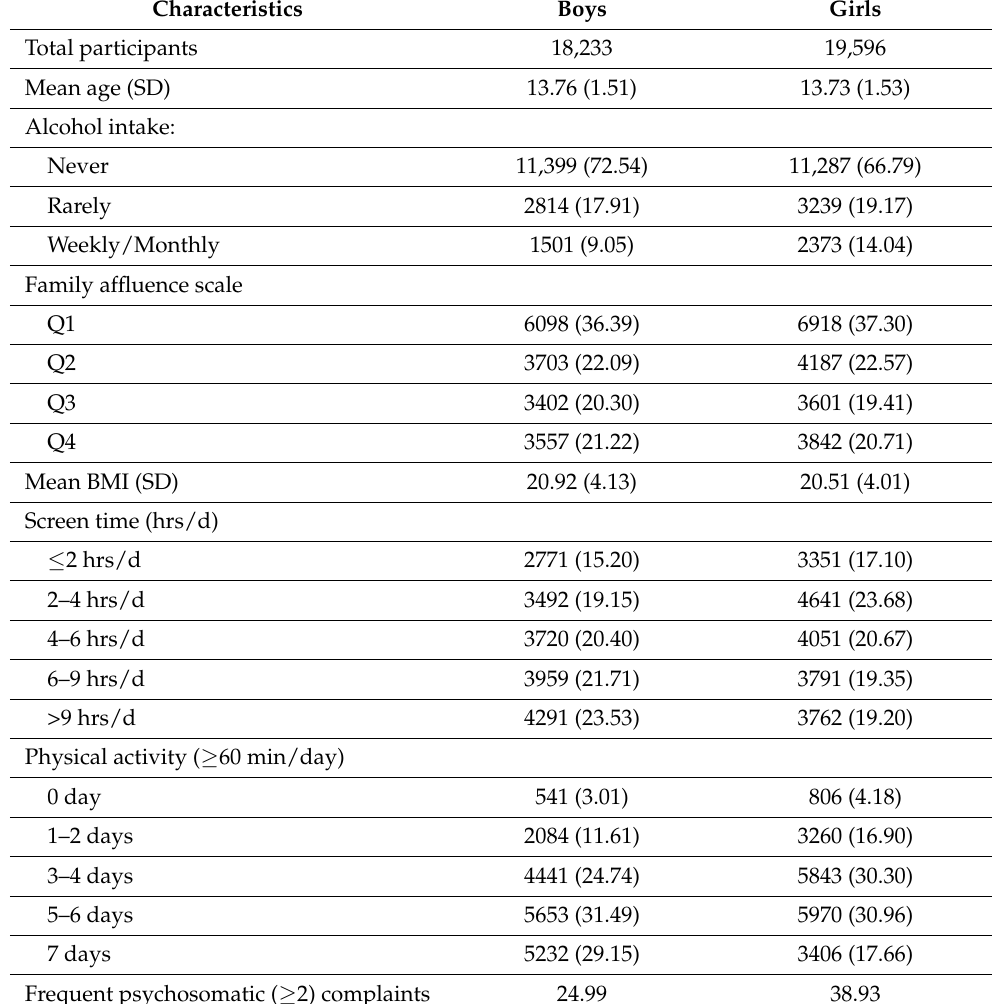
Table 1. Description of study sample, Canadian HBSC study, 2002–2014 ( n = 37,829).